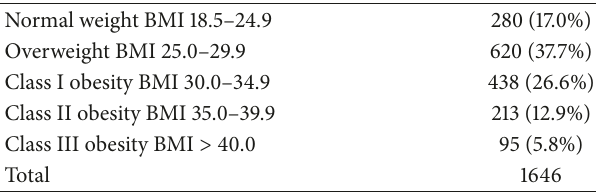
Table 3: Distribution of patients by BMI